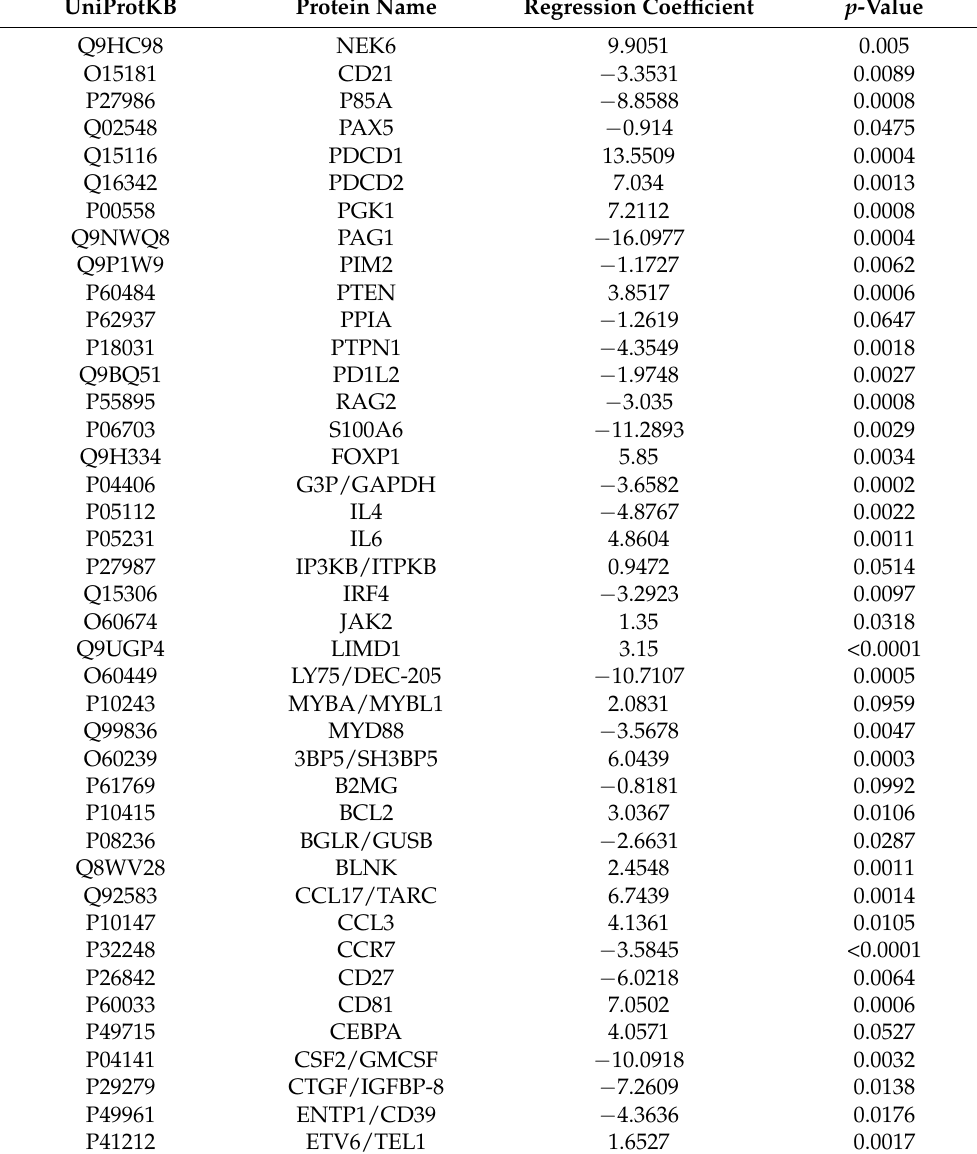
Table 2. Proteins significantly related to OS ( p < 0.05) in a univariate Cox